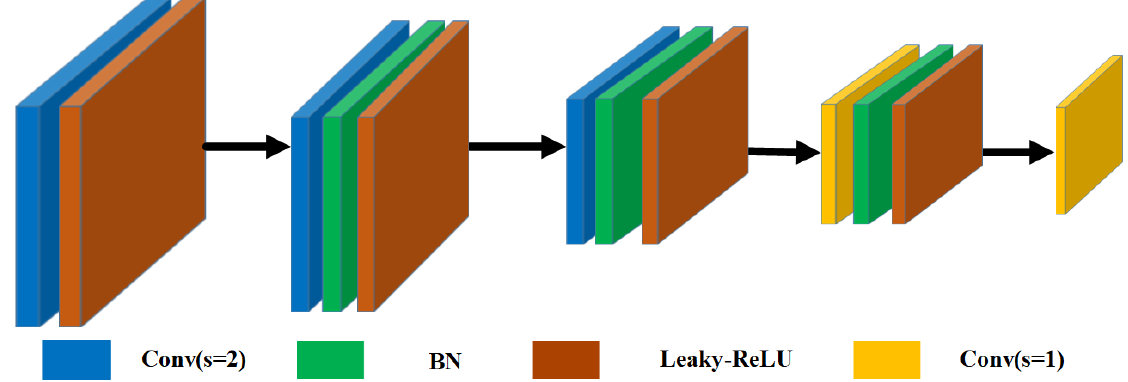
Figure 3. Architecture of the discriminator